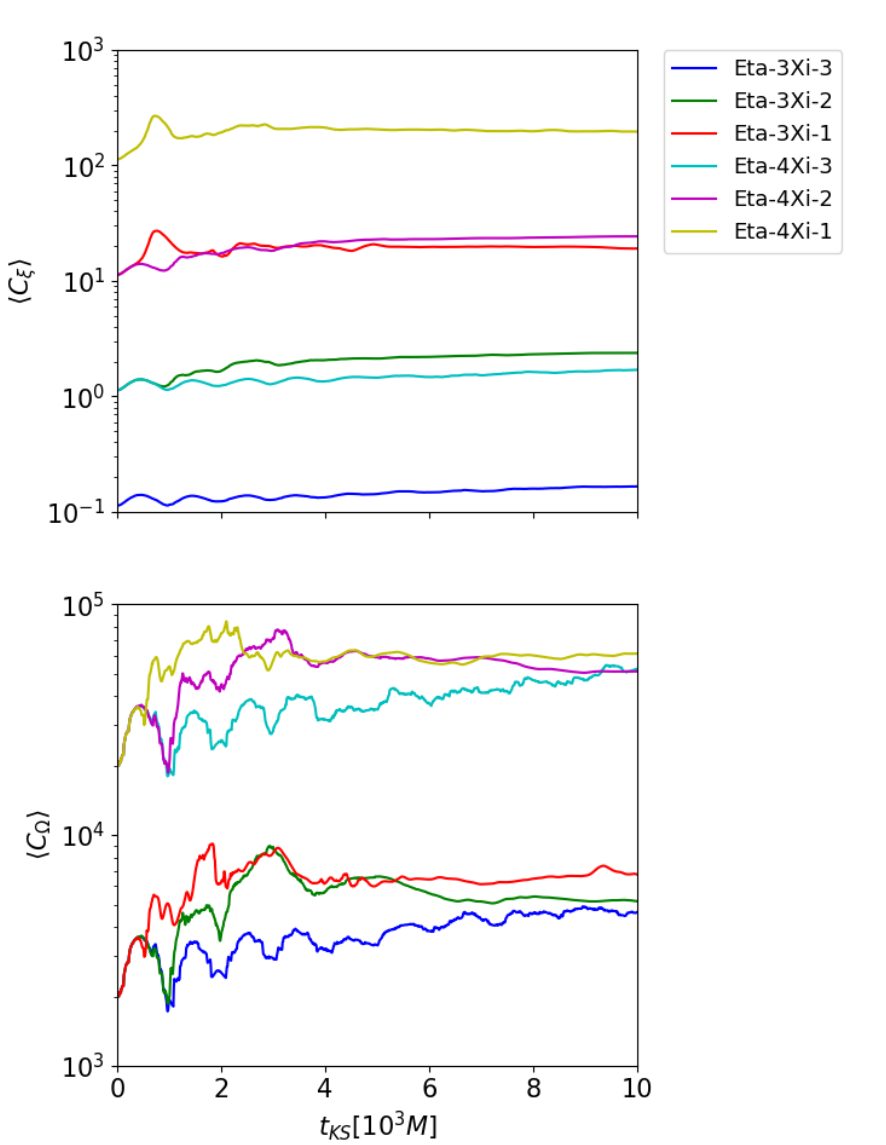
Figure 2. Time evolution of the dynamo numbers averaged on the disk for each